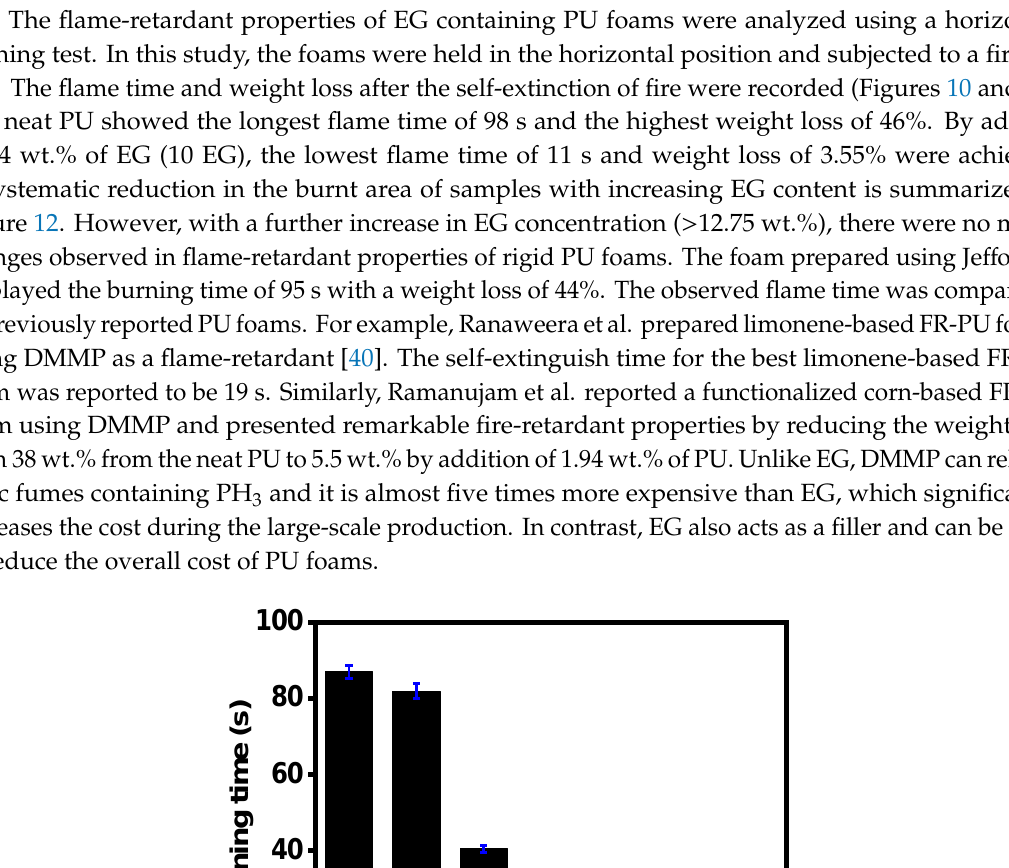
Figure 11. Weight loss for the PU foams with an increasing amount of EG after burning.